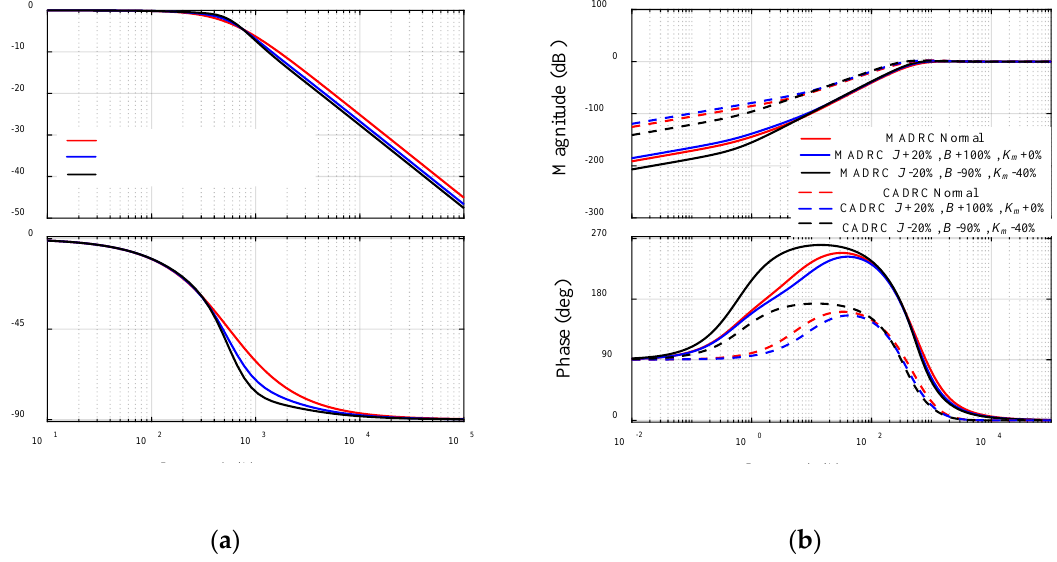
Figure 14. Frequency response of the speed–loop. ( a ) the frequency response of G cl ( s ) ; and ( b ) the frequency response of G cl ( s ) with parameter uncertainties.